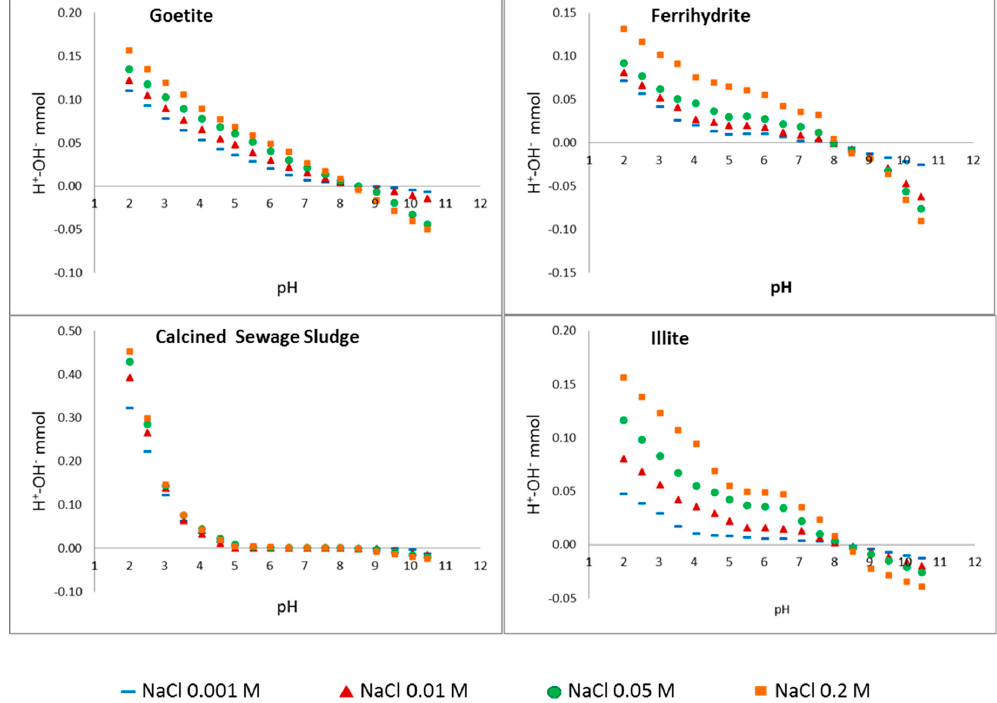
Figure 6. Experimental acid–base titration curves for iron oxyhydroxides, calcined sludge and illite obtained by the PZSE method at three ionic strengths and 25 °C.